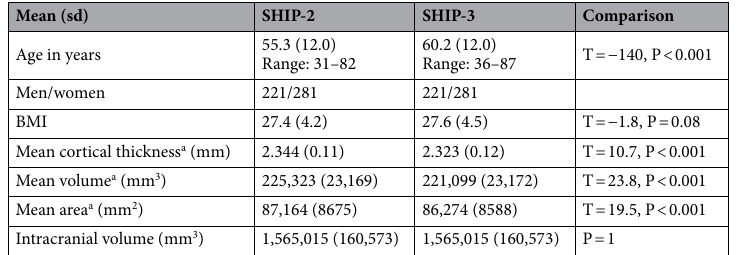
Table 1. Description of SHIP-2 and SHIP-3 sample with available longitudinal MRI data (N = 502). a Mean of left and right hemisphere, mean volume refers to mean